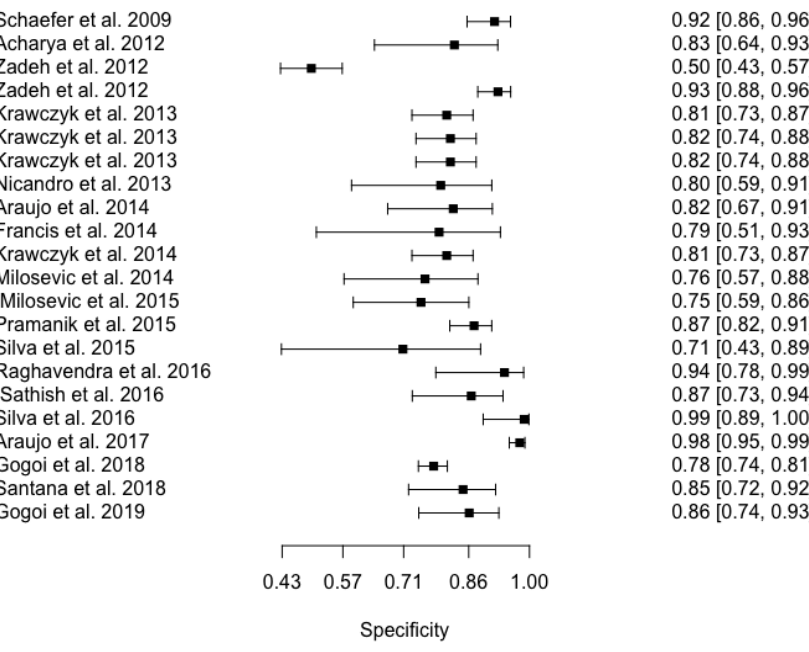
Figure A2. Forest plots for specificity for breast cancer studies.